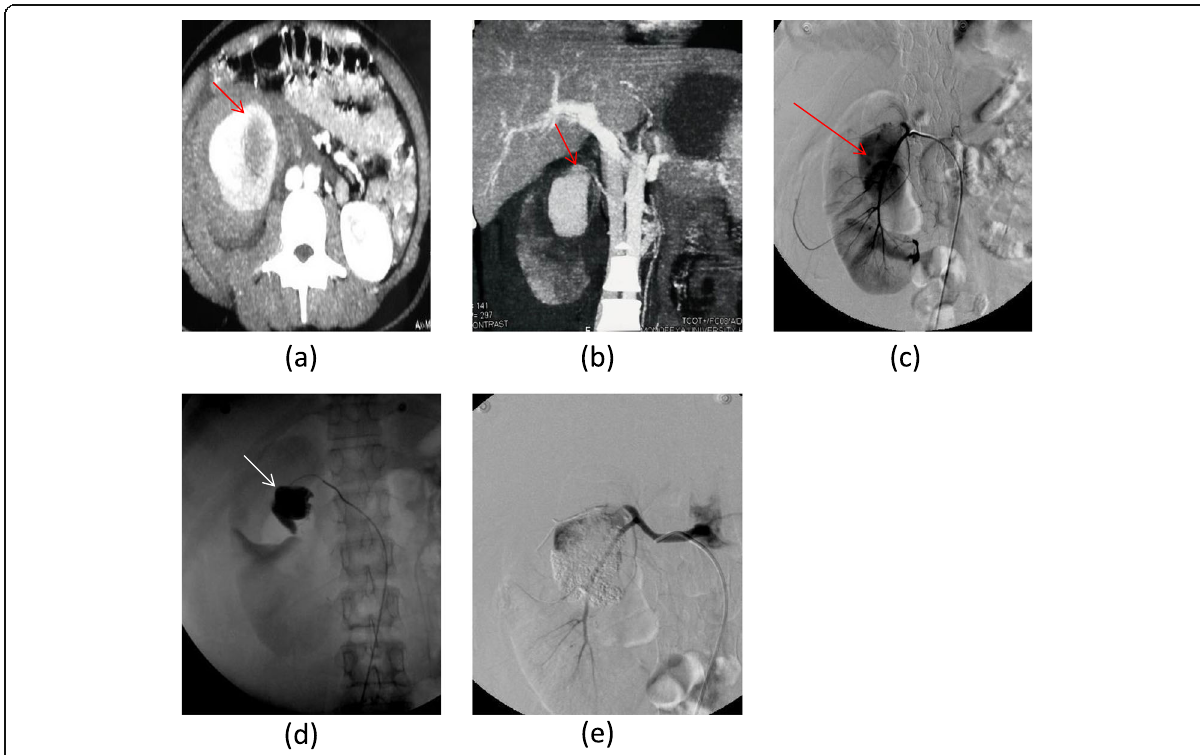
Fig. 3 A 38-year-old man had persistent massive hematuria due to a closed contusion of the right kidney in a car accident. Renal artery CTA ( a , b ) shows a giant pseudoaneurysm in the upper pole of the right kidney (red arrow). Angiography with the Cobra catheter ( c ) shows the pseudoaneurysm in the middle zone of the right kidney with leaking bleeding and there is contrast extravasation (long red arrow). NBCA glue was injected by microcatheter to fill the aneurysm forming thrombus ball (white arrow). Post-embolization angiography ( e ) shows occlusion of the pseudoaneurysmal sac and leak. The surrounding kidney tissues appear